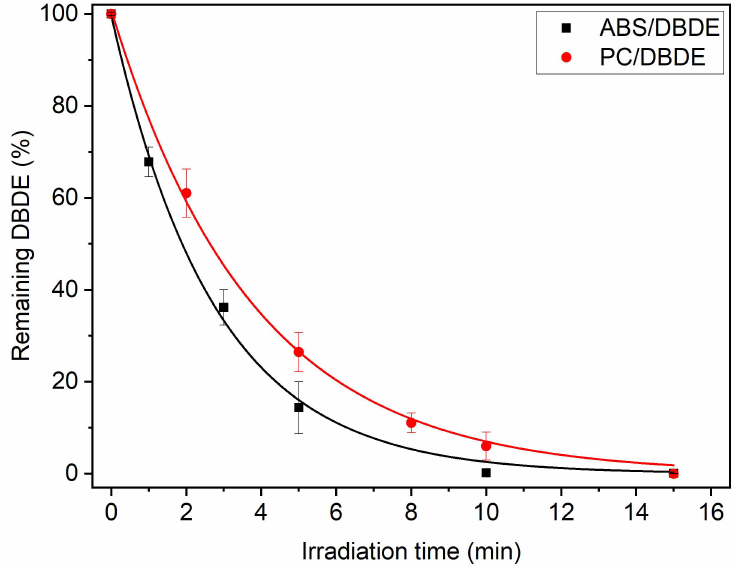
Figure 5. Decay profiles of remaining DBDE from 90 wt-% ABS/10 wt-% DBDE and 90 wt-% PC/10 wt-% DBDE films, obtained by